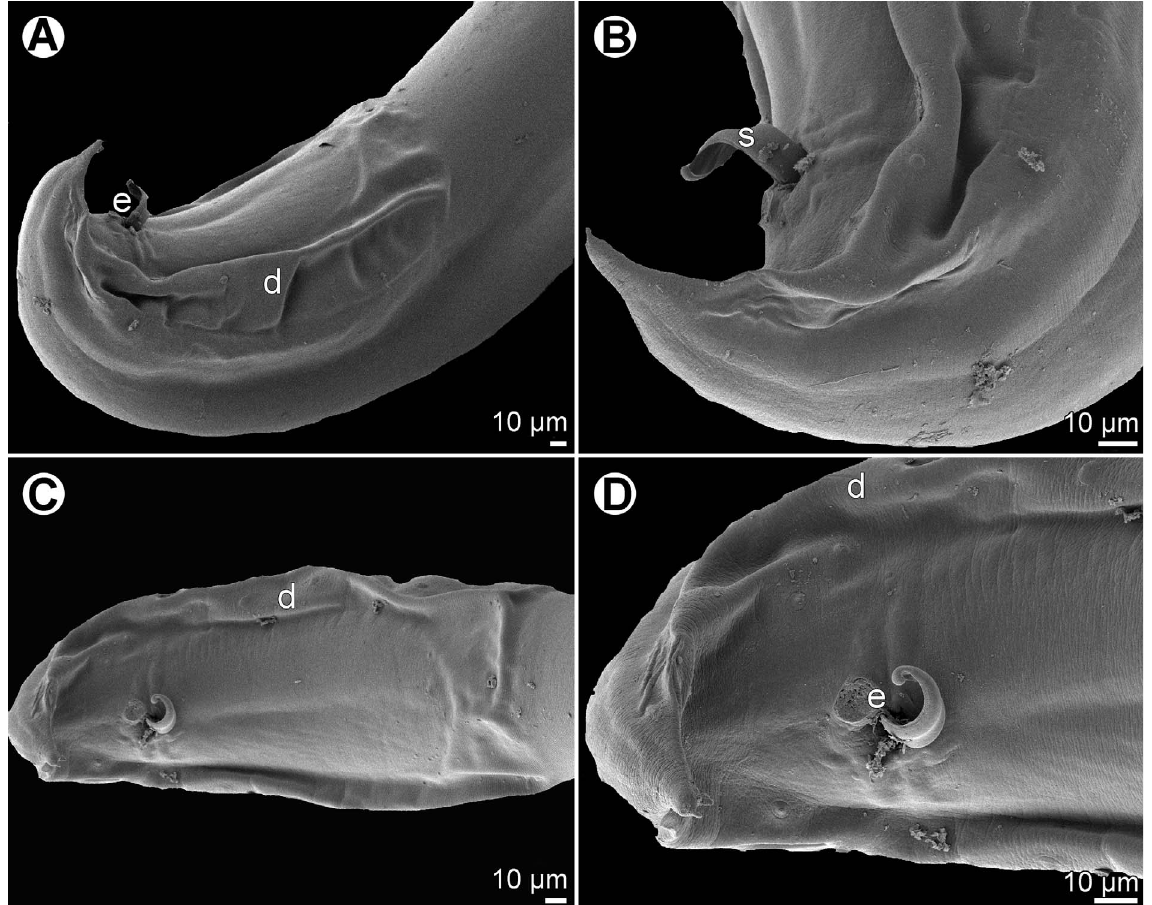
Figure 11. Procamallanus ( Spirocamallanus ) thalassomatis n. sp., scanning electron micrographs of male. (A) Posterior end of body, lateral view; (B) tail, lateral view; (C) posterior end of body, ventral view; (D) tail, ventral view. (d) caudal ala; (e) cloaca; (s)